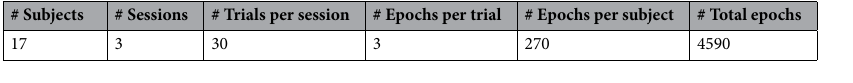
Table 1. Data-set